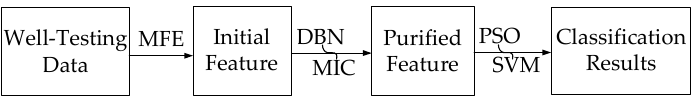
Figure 2. Diagram of oil test data analysis.